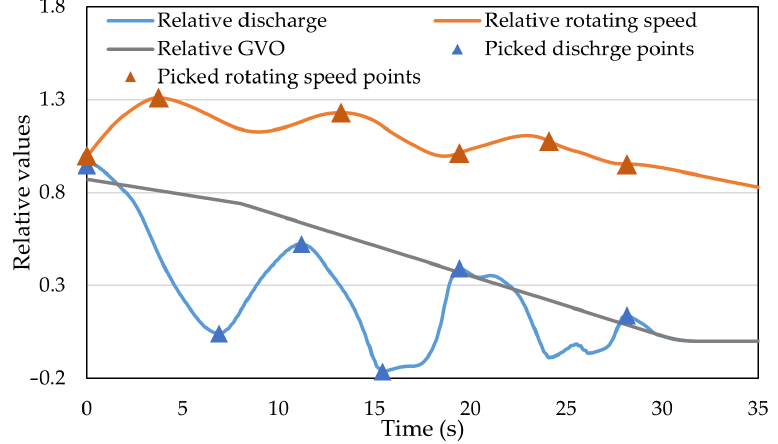
Figure 2. The operating parameters and 9 key time points of the PT unit during load rejection.